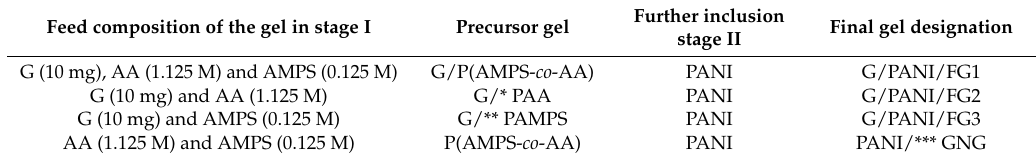
Table 1. Preparation of gels and designation.